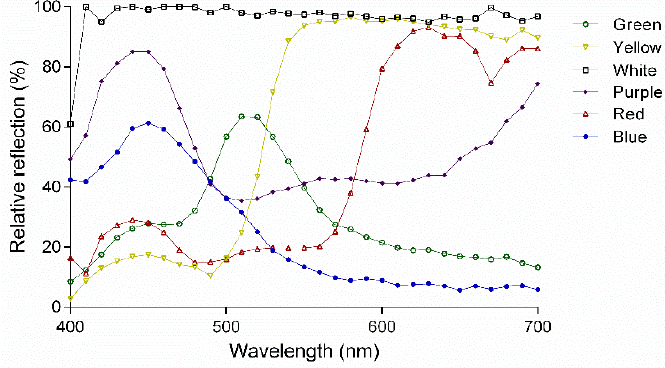
Figure 2. Spectral reflectance of color sticky cards used.